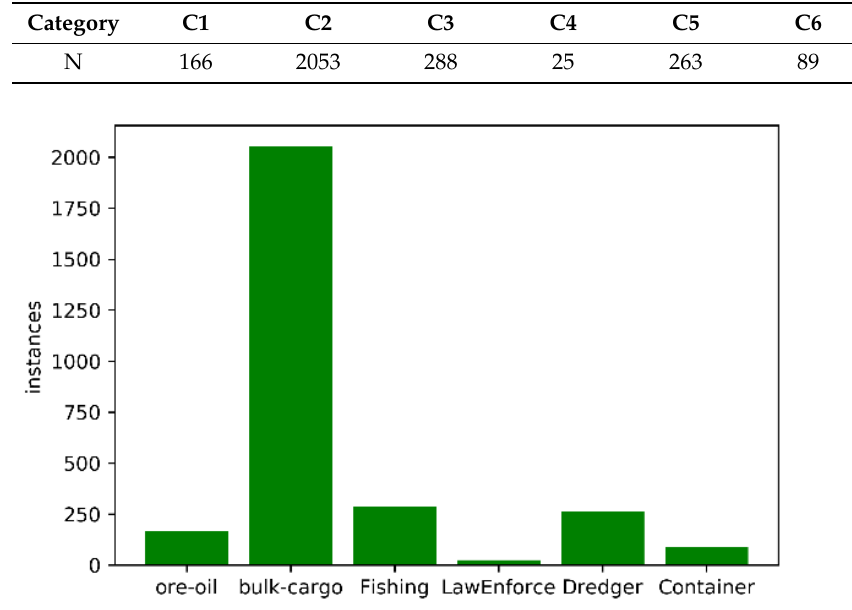
Figure 7. Histogram showing the distribution of different types of vessels in the dataset.